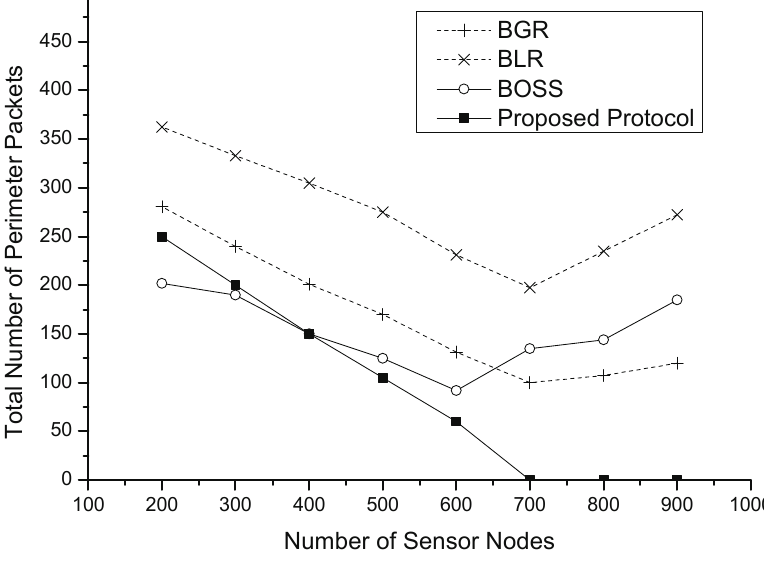
Figure 10. Total number of perimeter packets vs. the number of sensor